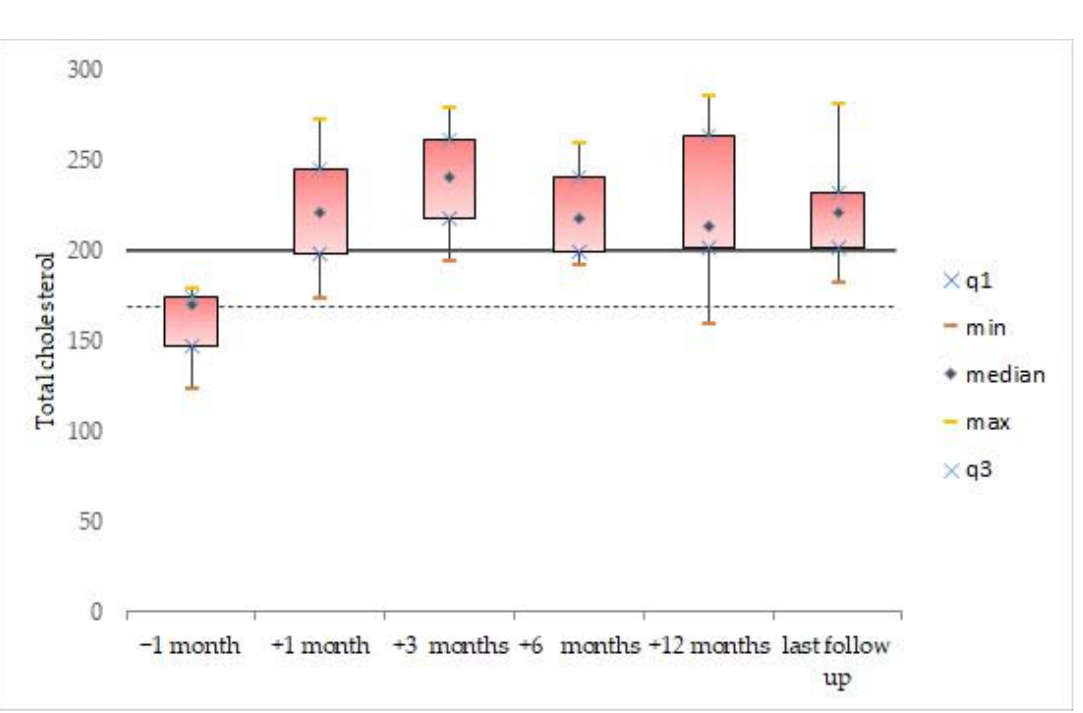
Figure 3 . Total cholesterol levels before and during vemurafenib. The dashed line indicates the ac ‐ ceptable upper limit, the double line indicates the borderline ‐ high limit according to the NCEP Ex ‐ pert Panel on Cholesterol Levels in Children.